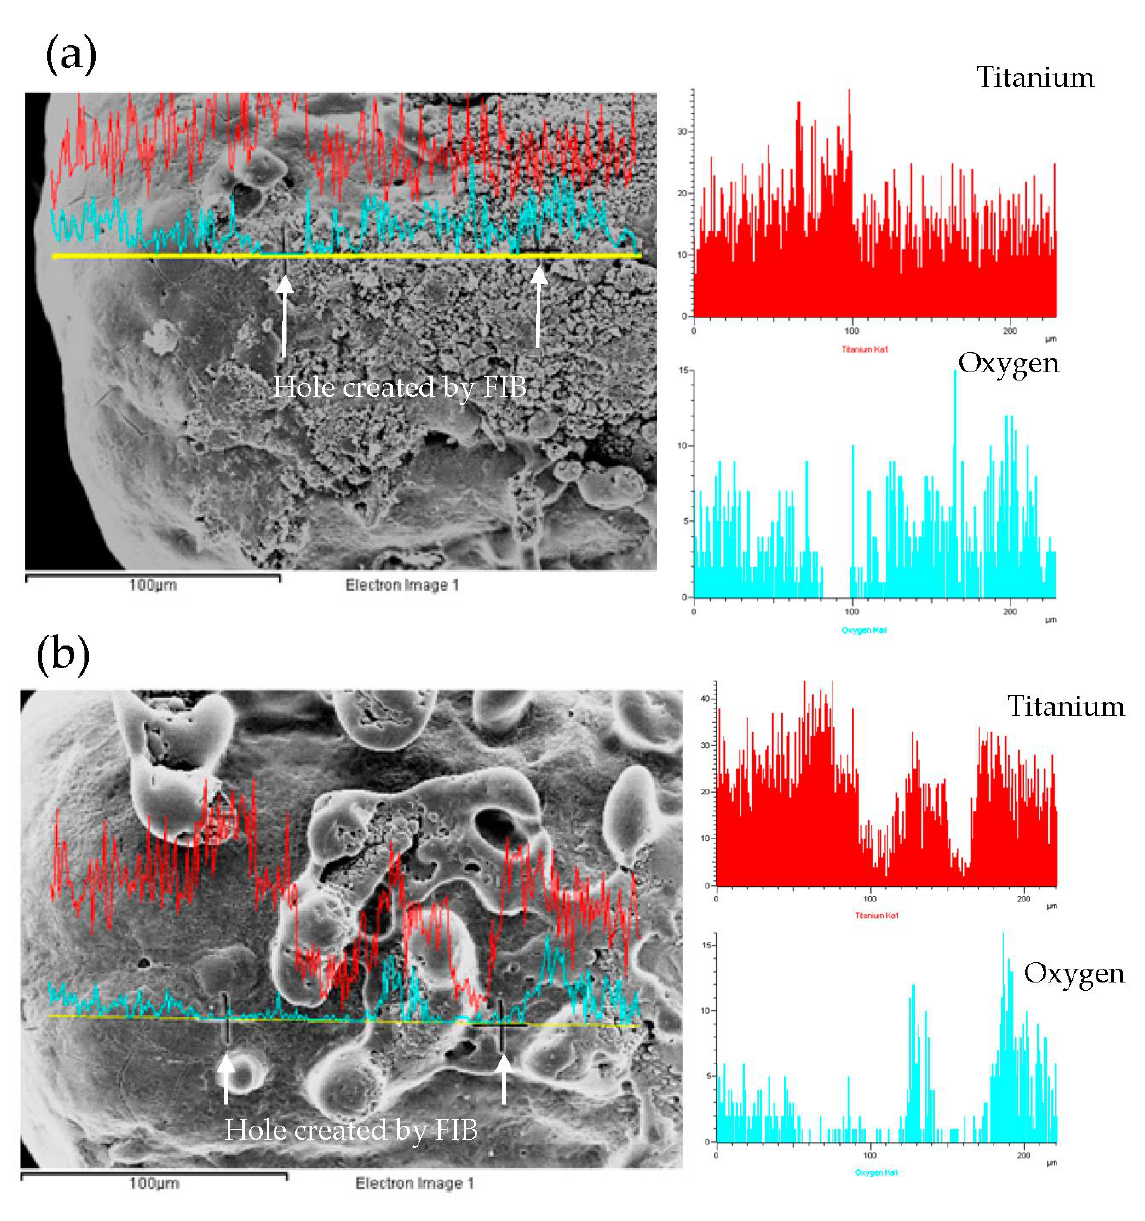
Figure 6a,b illustrate the SEM images and EDS line scan result of the sparked anode and cathode titanium tips, respectively. At the tip of the anode electrode, a large titanium ratio and a small amount of oxide cover were found. Given that there was no oxygen found at the aperture created by the focus ion beam (FIB), we can conclude that the oxygen was only on the surface. The oxygen content increased in the nanoporous film area due to the formation of titanium oxide in that area. As was the case with the anode, the oxygen content also increased in the cluster of nanoporous material on the cathode.